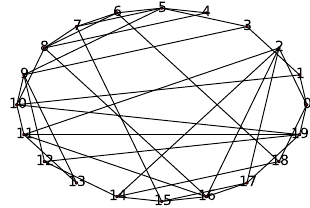
Figure 9. Small-world network 3.